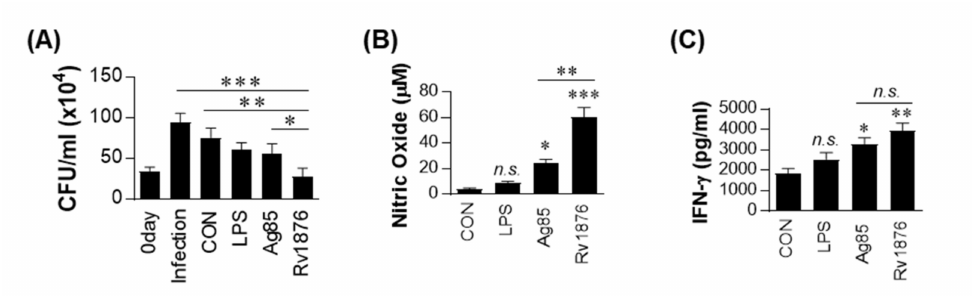
Figure 3. T cells activated by Rv1876-maturated DCs inhibit intracellular Mtb growth. Ag85